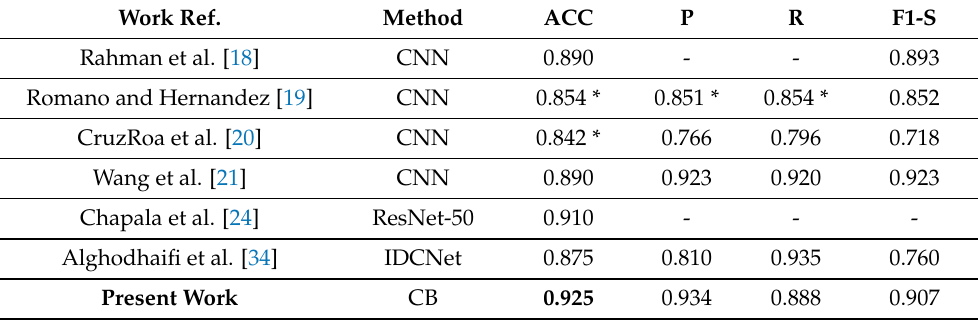
Table 5. Comparison with state-of-the-art methods on CXR images. In this table, ACC, P, R, F1-S and AUC indicate the accuracy, precision, recall, F1-score and area under ROC curve, respectively. Bold face scores indicate the best performance while ‘-’ indicates that the specific value is not available. ACC with ‘*’ represents balanced